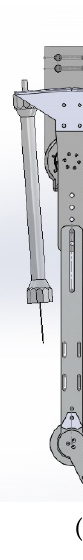
Figure 4. Thigh length adjustment: ( a ) 37.2 cm; ( b ) 52 cm.